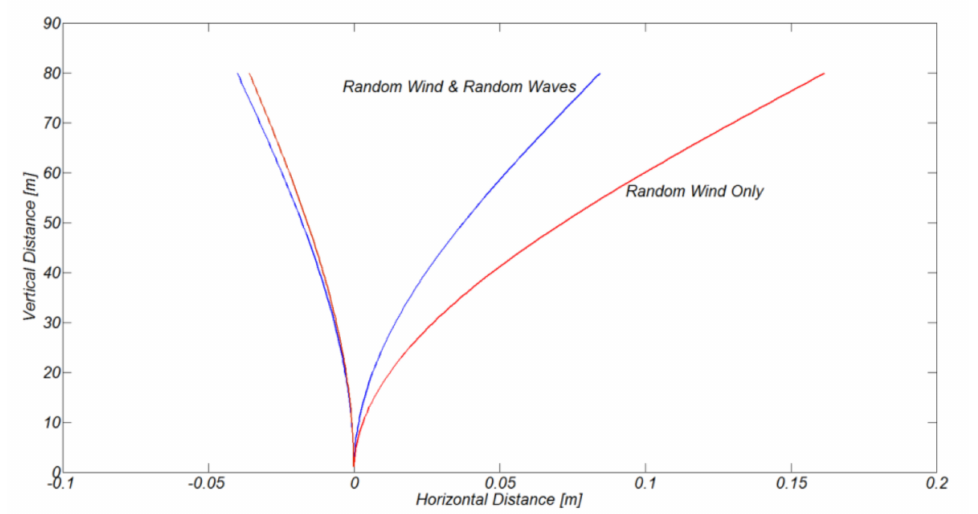
Figure 17. Instantaneous snapshots of the deflection of the o ff shore wind turbine substructure at its extreme against di ff erent combinations of external